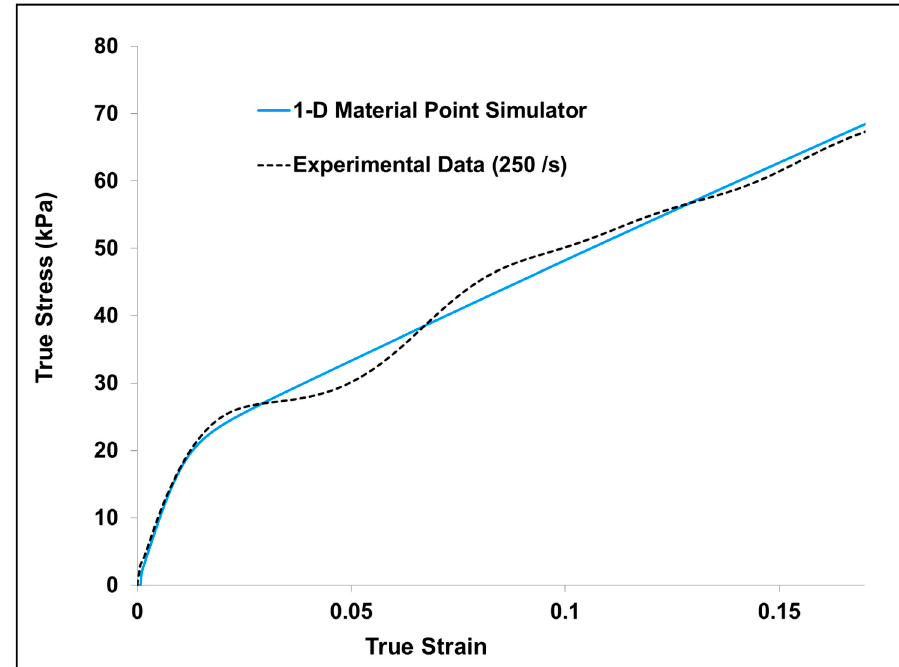
Figure A2. Comparison of experiment and one-dimensional (1-D) material point simulator σ 33 for dry porcine brain sample compression at 250 s − 1 . The material parameters for MSU TP Ver.1.1 material model were calibrated to the experimental data.